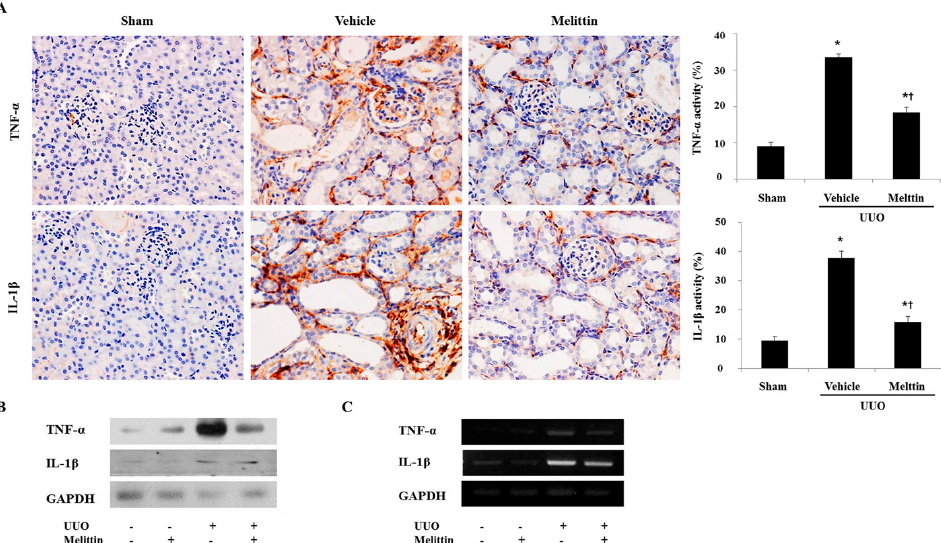
Figure 2. Melittin attenuates the expression of pro-inflammatory cytokine in obstructed kidneys. ( A ) Immunohistochemical staining shows that melittin inhibits the expressions of tumor necrosis factor (TNF)- α and interleukin (IL)-1 β in kidneys at 7 days after unilateral ureteral obstruction (UUO) surgery. Immunohistochemical staining was used to evaluate the extent of pro-inflammatory cytokines, which was subsequently quantified. ( B , C ) Western blot analysis and Reverse transcription-polymerase chain reaction (RT-PCR) results show that melittin suppresses the protein and mRNA expressions of TNF- α and IL-1 β in UUO kidneys. Glyceraldehyde-3-phosphate-dehydrogenase (GAPDH) levels were analyzed as an internal control. − : not treated, +: treated. These are representative images from each study group. Magnification: 400 × . The results are expressed as means ± SE of three independent determinations. * p < 0.05 vs. Sham group. † p < 0.05 vs. Vehicle group.